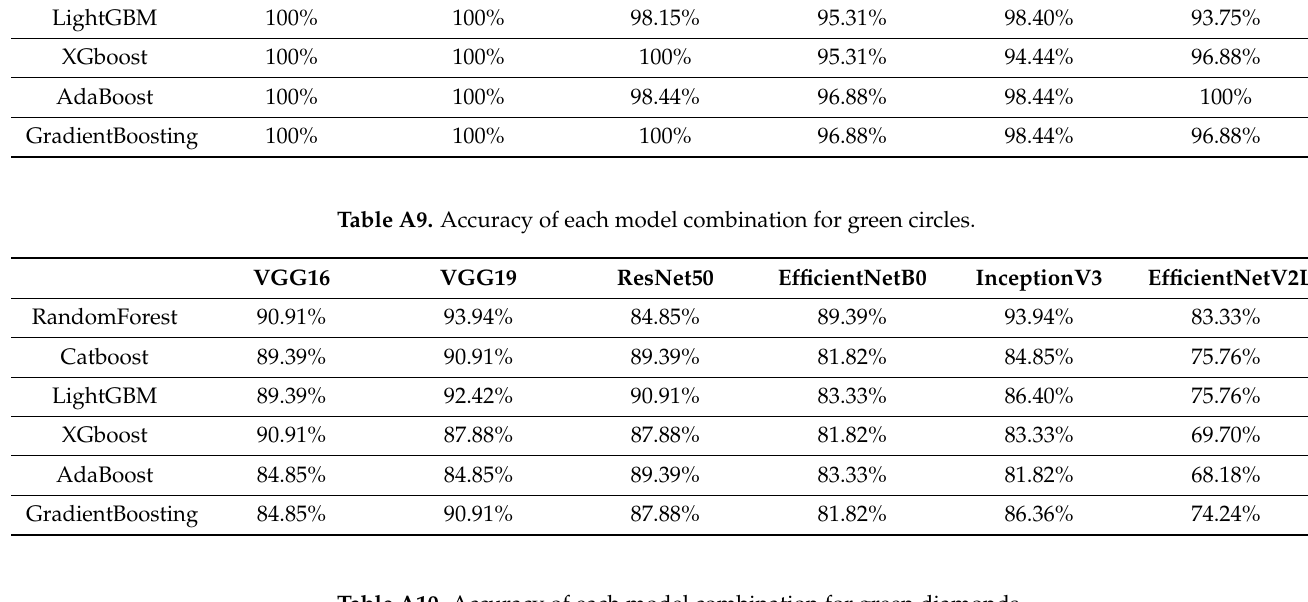
Table A10. Accuracy of each model combination for green diamonds.